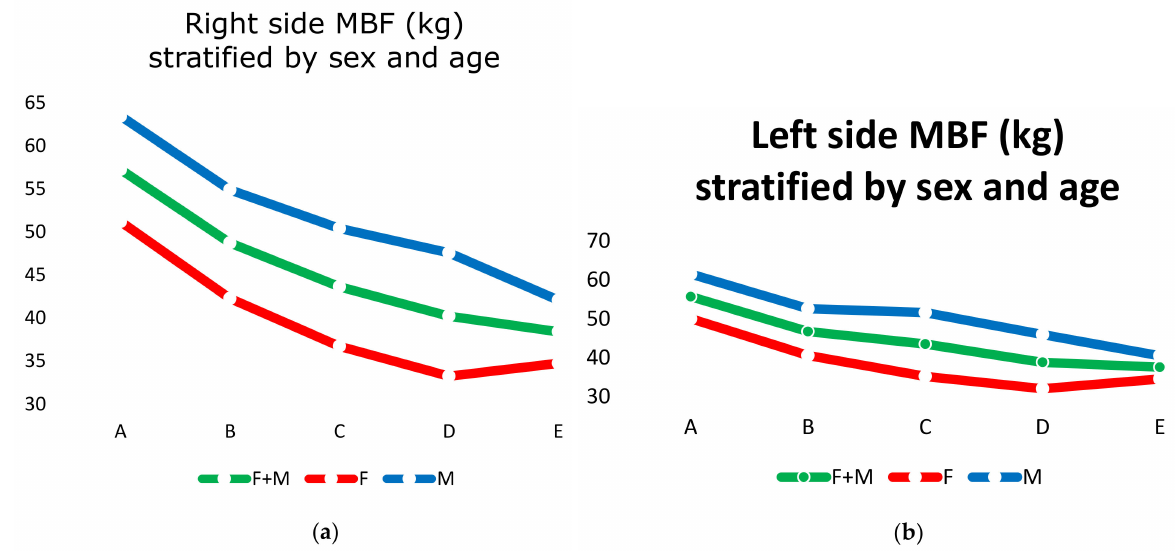
Figure 1. ( a ) Right side MBF (kg) stratified by sex and age; ( b ) left side MBF (kg) stratified by sex and age.